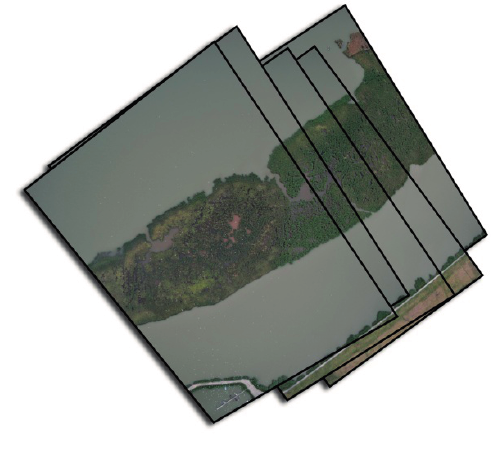
Figure 4. Aerial images of line 1 before photogrammetric processing.